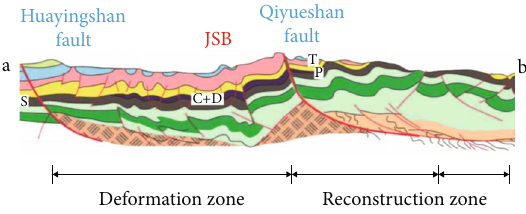
Deformation zone Reconstruction Figure 2: The pro fi le of the structural deformation area of Sichuan Basin (modi fi ed after